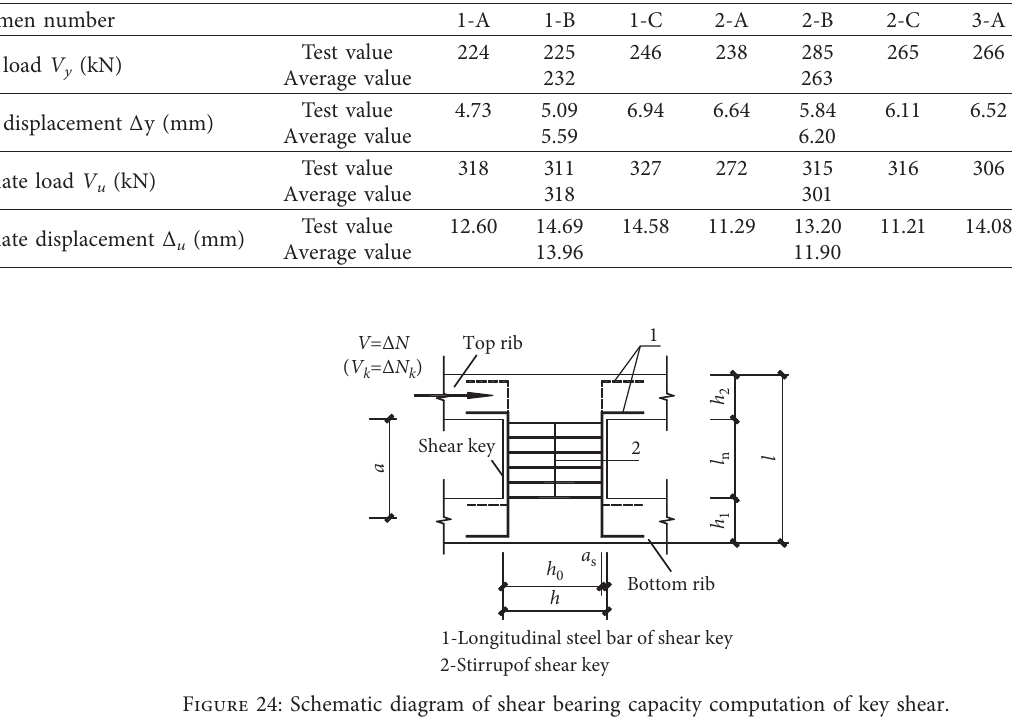
Table 4: Main test results.